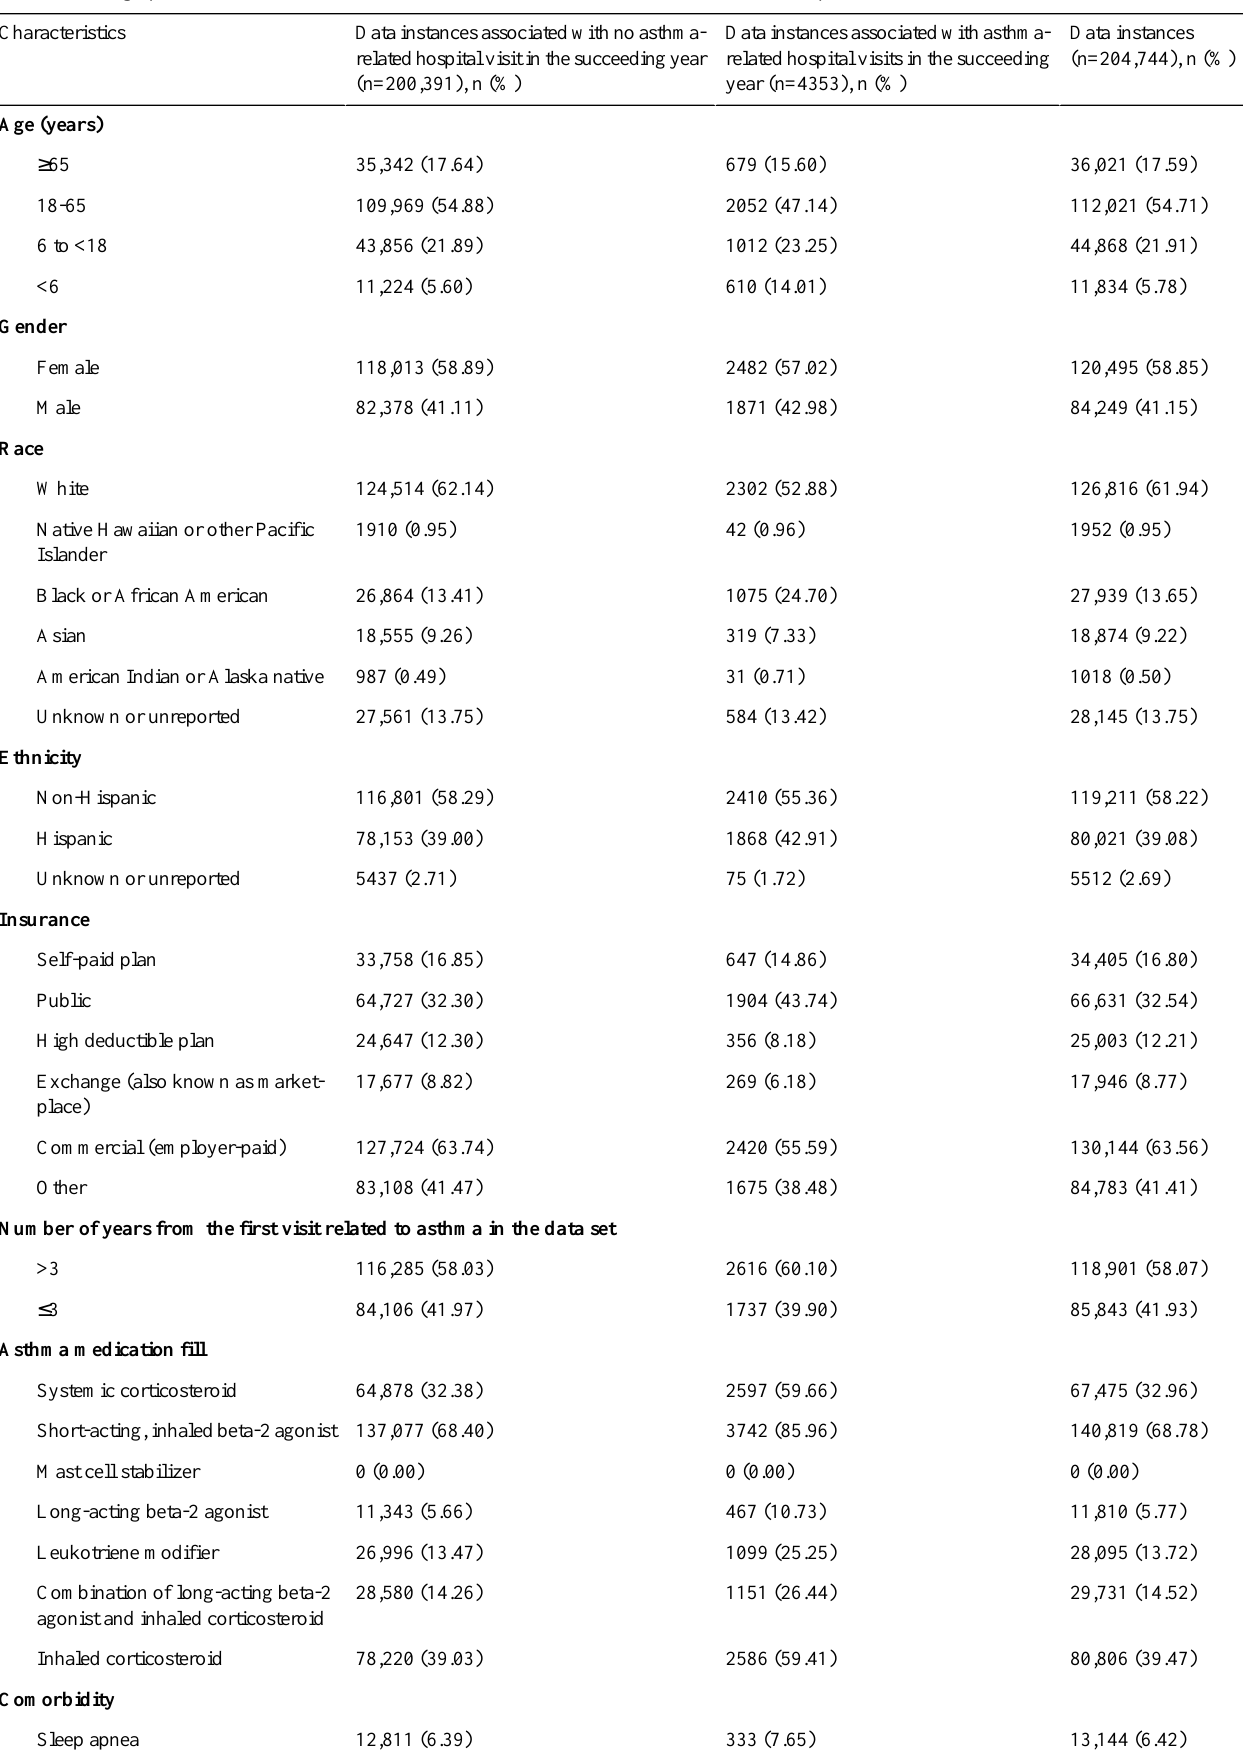
Table 2. Demographic and clinical characteristics of our Kaiser Permanente Southern California patient cohort in 2017.